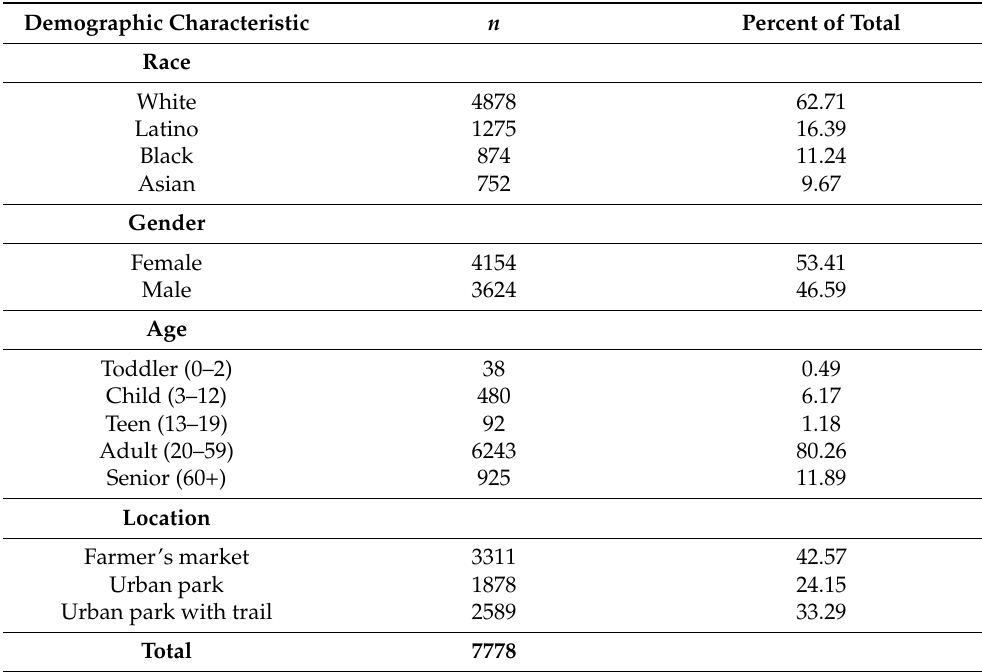
Table 1. Descriptive statistics of the SOMAD observations in Houston, TX.